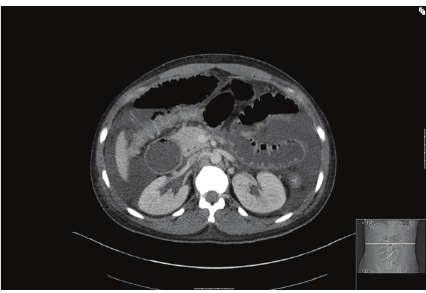
Figure 2: Repeat contrast enhanced CT of the abdomen and pelvis at day 3 after admission revealed pneumatosis involving the distal jejunum, proximal ileum, and diffusely dilated small bowel loops as well as segmented submucosal thickening of the small